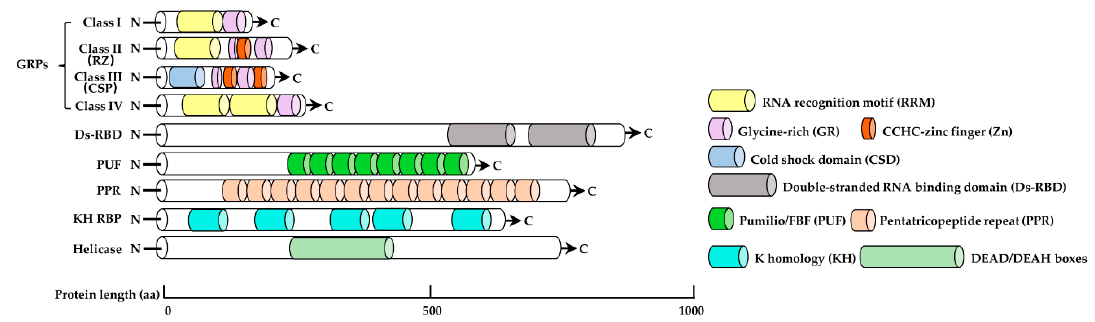
Figure 1. Structure diagram for different types of RNA-binding protein (RBP) from Arabidopsis thaliana described in this review (the left ). The well-known RNA-binding domains (RBDs) and auxiliary motifs in plants (the right ).